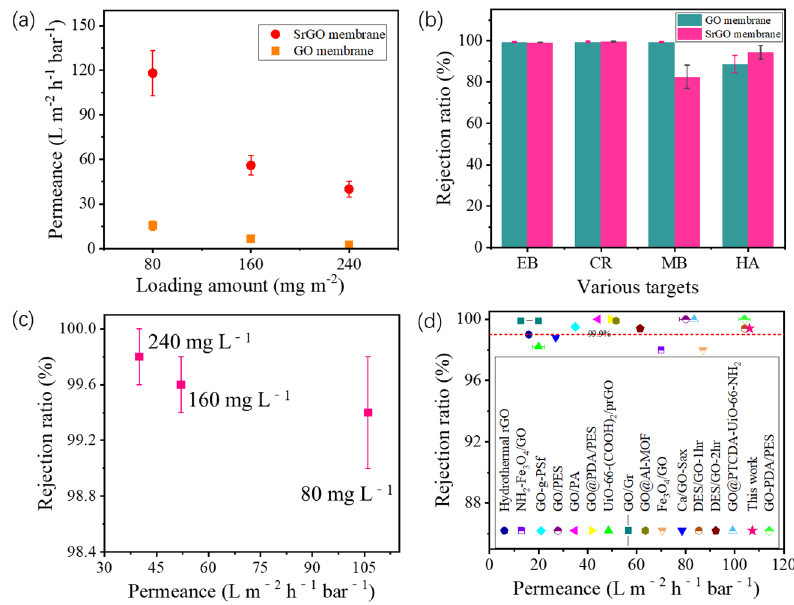
Figure 4. ( a ) Permeances of SrGO membranes and GO membranes with various loading amounts; ( b ) Rejection ratios of SrGO membranes and GO membranes toward various molecules; ( c ) Permeance and rejection ability toward CR of SrGO membranes with various loading amounts; ( d ) Performance comparison of the SrGO membranes and other graphene-based membranes in terms of their permeance and rejection ability toward CR (references are shown in Table S2).